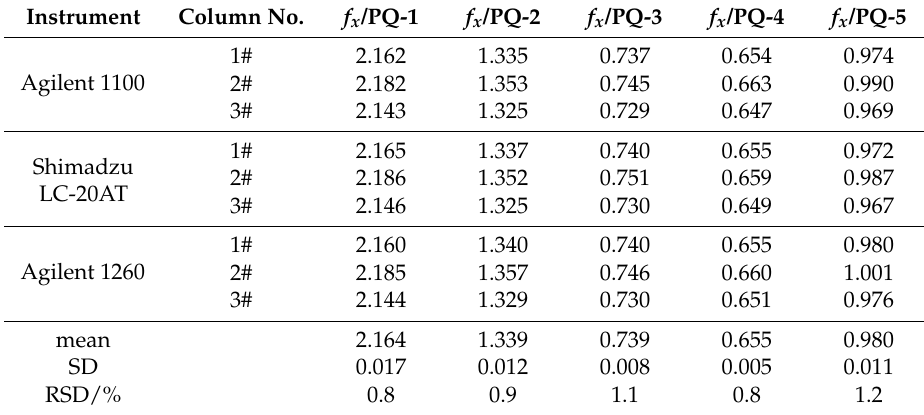
Table 4. Results of robustness test for RCFs determination 1